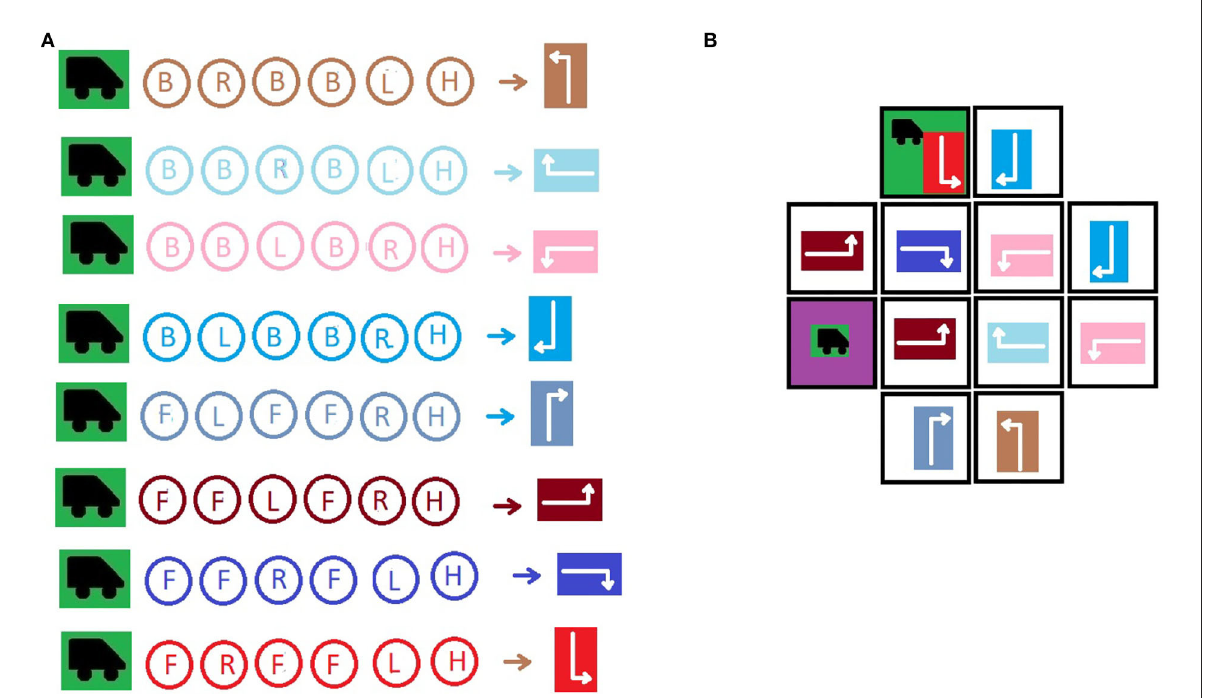
FIGURE11 Steps to solve the problem with 11 functions of knight moves. (A) Definition of each knight move. (B) Solution of the knight